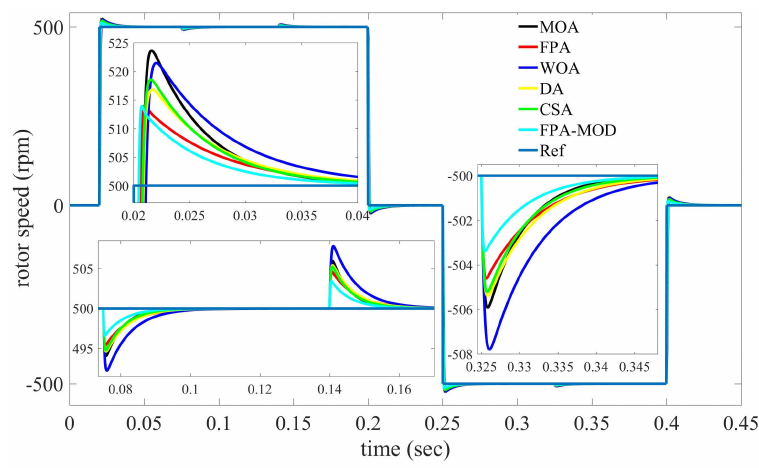
Figure 12. Simulation result for speed tracking task, Case 4.